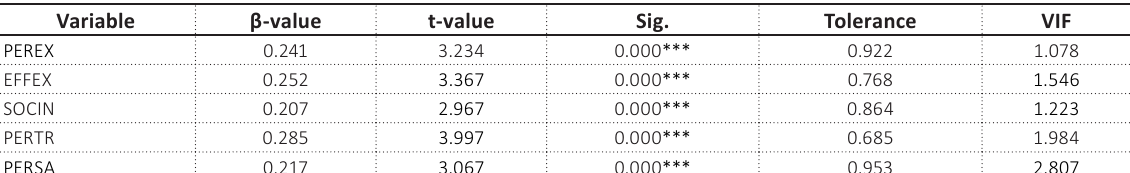
Table 3. Regression coefficients